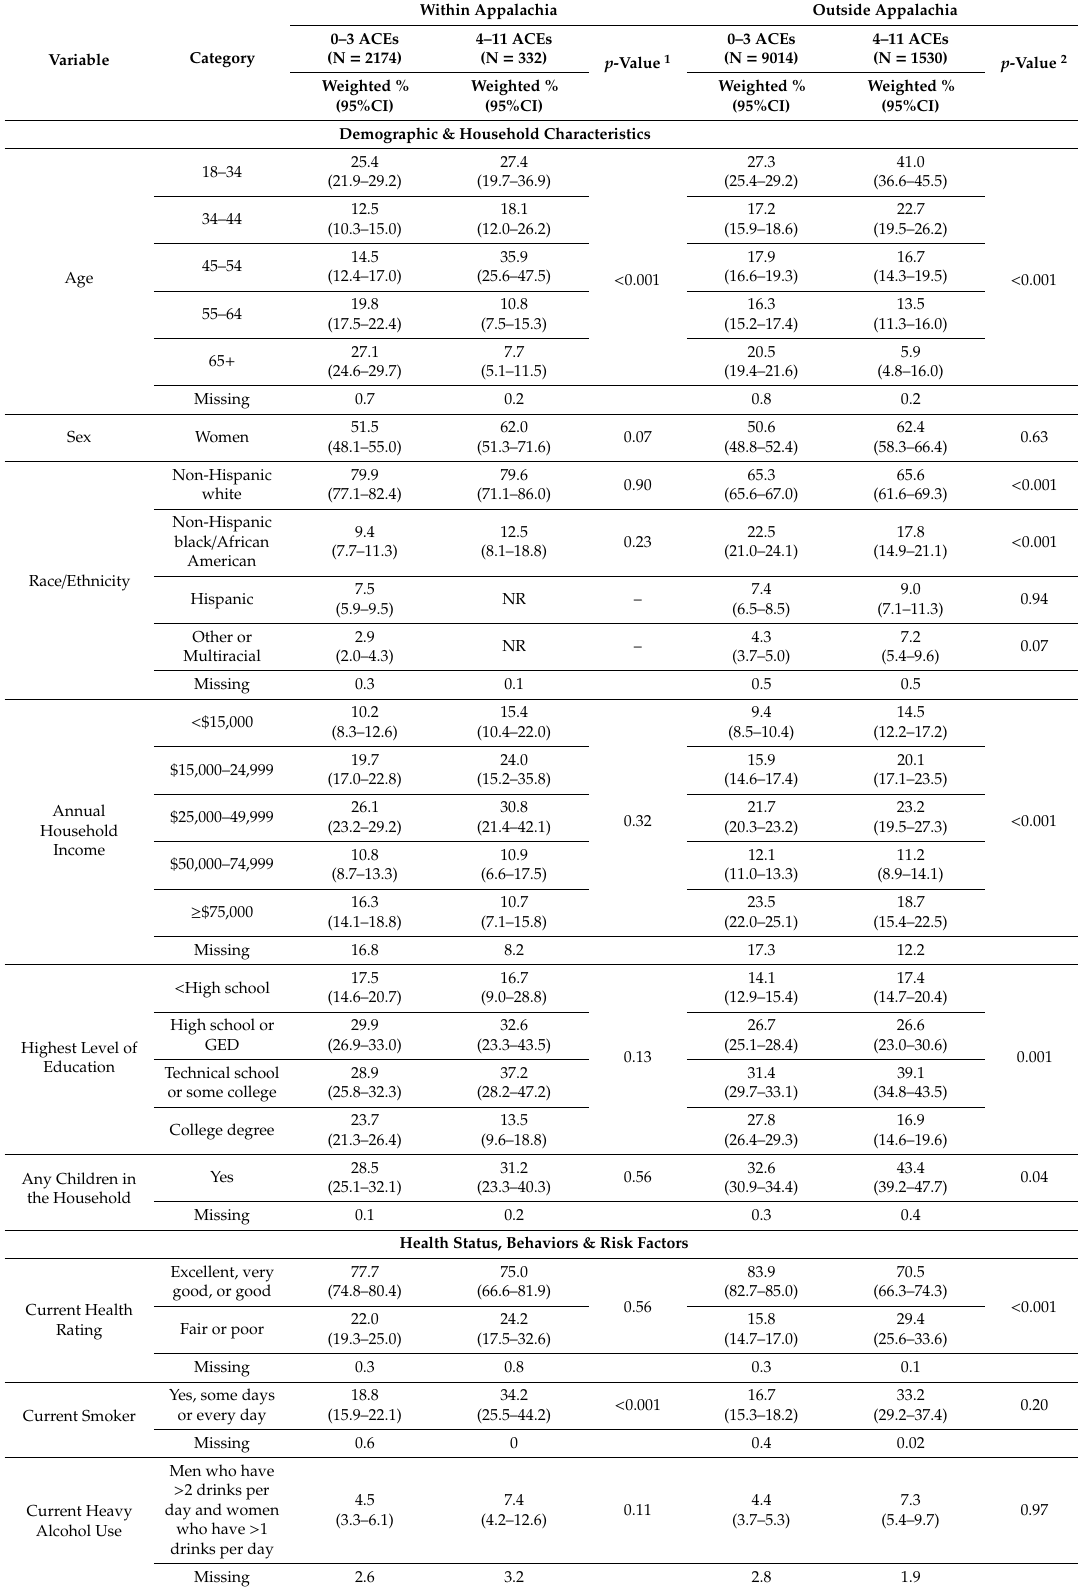
Table 2. Characteristics of respondents and ACEs within Appalachia and outside Appalachia, North Carolina, 2012 &